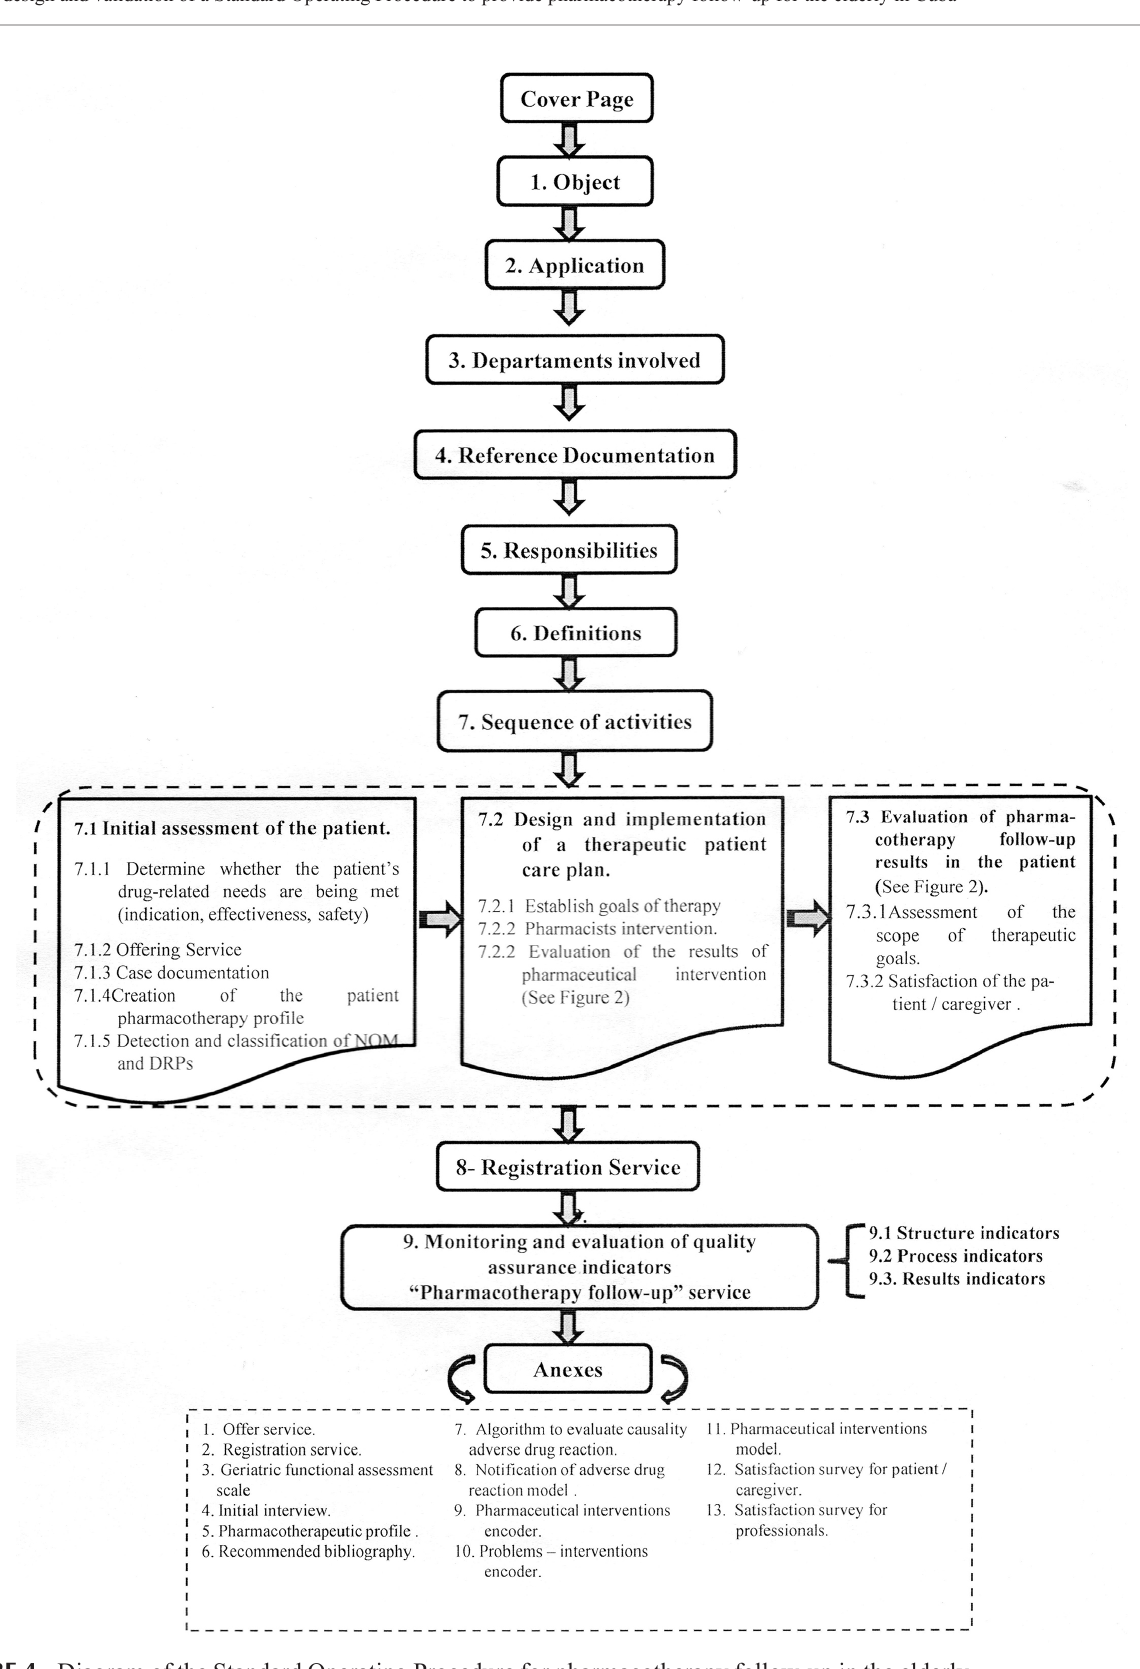
FIGURE 4 - Diagram of the Standard Operating Procedure for pharmacotherapy follow-up in the elderly. Legend: DRPs: Drugs-Related Problems. NOM: Negative Outcomes associates with